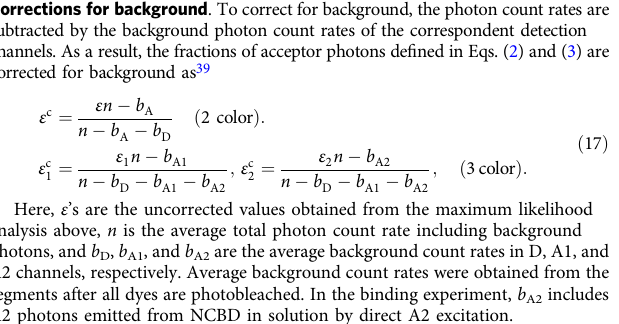
Here, ε 1 and ε 2 are the background and donor-leak corrected fractions (Eqs. (17) and (19)), E 1 , E 2 , and E 12 are the true FRET ef fi ciencies, which are found from two-color segments and/or using Eqs. (6) – (8) iteratively. For example, when E 2c 2 is known (i.e., determined from DA2 segments), E 3c 1 and E 3c 12 are found iteratively using Eqs. (8) and (22) with uncorrected ε 1 and ε 2 as initial values. Since f dir 1 and f dir 2 are small, the values converge after several iterations. Experimentally, the γ -factors were determined by comparing the count rates before and after acceptor photobleaching. γ 1 = ( η A1 ϕ A1 )/( η D ϕ D ) is 1.51 and γ 2 = ( η A2 ϕ A2 )/( η D ϕ D ) is 0.75 for α 3 D folding, and γ 1 = 0.83 and γ 2 = 0.49 for TAD/ NCBD binding. f dir 1 and f dir 2 are 0.067 and 0.072, respectively. Since the fl uorescence signal by direct excitation of A2 of unbound NCBD in solution is treated as background in A2 channel, we set f dir 2 = 0 for the unbound state (TAD only) in the binding experiment. Gaussian chain model . When the inter-dye distances fl uctuate, the FRET ef fi - ciencies determined from the three-color segments differ from those determined from the two-color segments 18 . The two-color FRET ef fi ciency is the average with respect to the fl uctuation of only one donor – acceptor distance. In three-color FRET, fl uctuations of all three distances in fl uence the measured acceptor fractions and the FRET ef fi ciencies calculated using Eqs. (6) – (8). Therefore, it is natural that the FRET ef fi ciencies obtained from the two-color and from the three-color seg- ments are different in the case of fl uctuating distances. This effect can be evaluated by calculating the three-color FRET ef fi ciencies using the Gaussian chain model for the unfolded state of the protein. The parameters of the model are extracted from the two-color FRET ef fi ciencies. The Gaussian chain model involves only the mean-squared distance 〈 r i 2 〉 as a parameter. In α 3 D construct, the two vectors, r 1 connecting D and A1 and r 12 connecting A1 and A2 (Fig. 1a), are assumed to be independent and have a Gaussian distribution, so r 2 = r 1 + r 12 has also the Gaussian distribution with 〈 r 2 〉 = 〈 r 2 〉 + 〈 r 2 〉 . Thus, the inter-dye distance distributions are 2 1 12